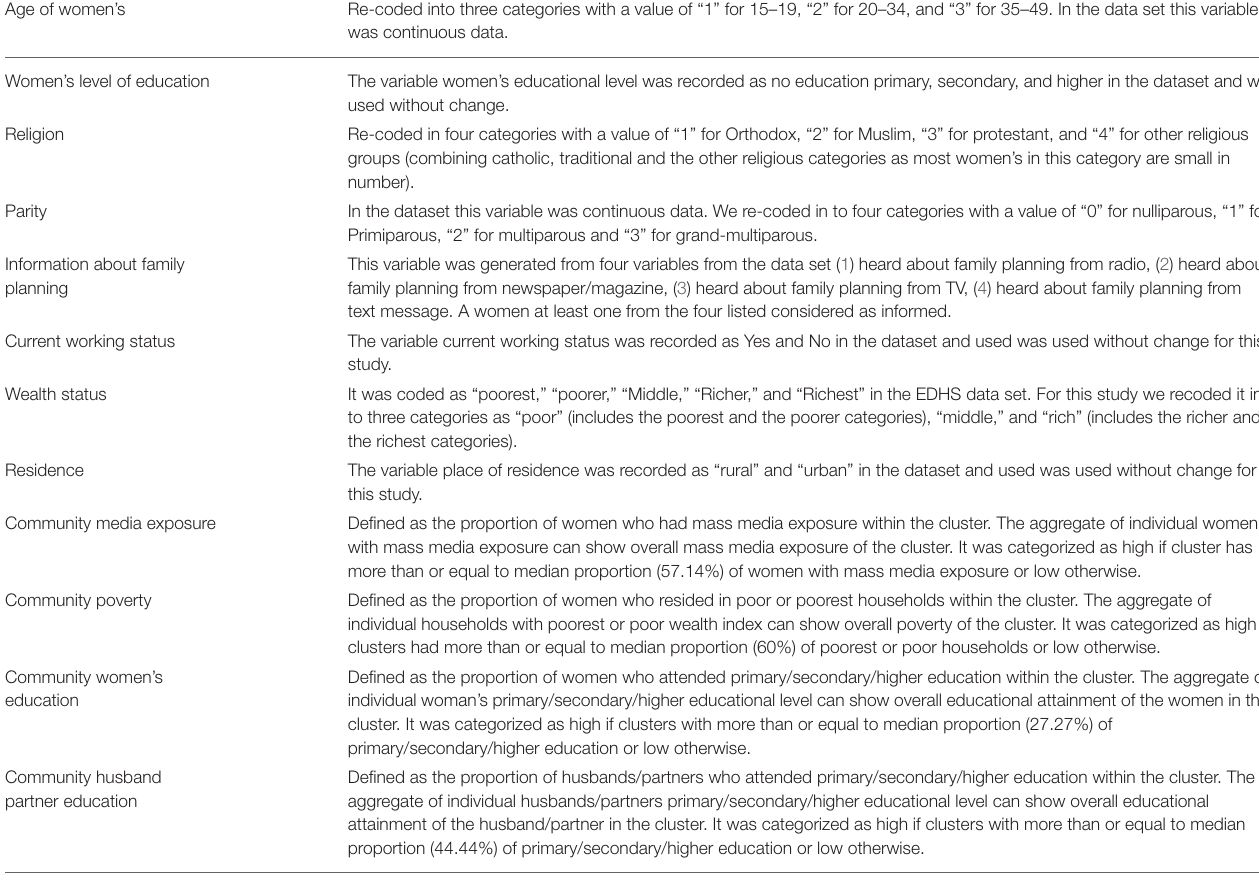
TABLE 1 | Description and measurement of independent variables. Age of